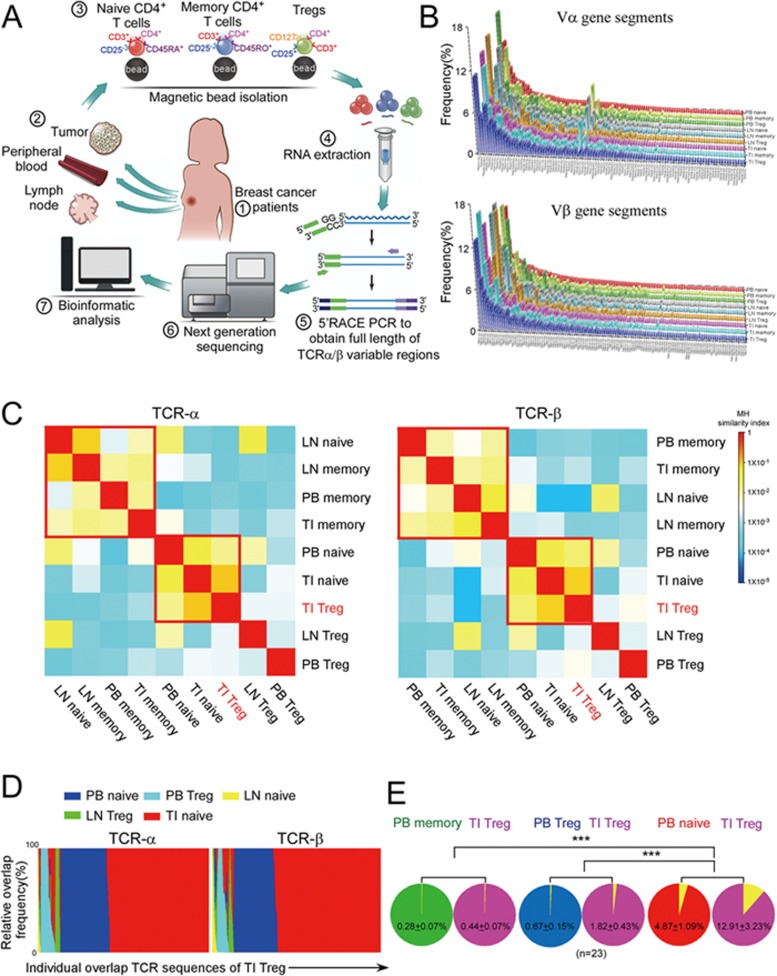
The TCR repertoire of breast cancer tumor-infiltrating Tregs is most similar to that of naive CD4+ T cells. (A-D) Full-length TCR-β/α variable regions of Tregs, naive CD4+ T cells and memory CD4+ T cells from peripheral blood (PB), lymph nodes (LN) and primary tumors (tumor-infiltrating, TI) of five breast cancer patients were amplified and sequenced. Pooled data from all five patients were compared. (A) Experimental schematic. (B) Frequencies of Vα/β gene usage in the groups of isolated T cells (V genes were ordered based on decreasing frequency in PB naive CD4+ T cells). (C) Similarity of pooled TCR repertoires, calculated using the Morisita-Horn similarity index16, was used to cluster the groups of T cells analyzed. A value between 0 (no similarity) and 1 (identical) was calculated and colored according to the shown scale. (D) Individual overlap sequences of TI Treg identified in other groups of T cells. Individual TCR sequences of TI Tregs were arrayed on the x axis and the relative frequency at which this particular sequence was found in other subsets was plotted on the y axis. (E) Proportion of unique TRBV12-4/TRBJ1-2 sequences shared between TI Tregs and the 3 PB T cell subtypes (Treg, naive and memory CD4 T cells) in 23 breast cancer patient samples (shown are proportion of overlapping sequences (mean ± SEM), ***P < 0.001 by Student's t-test).